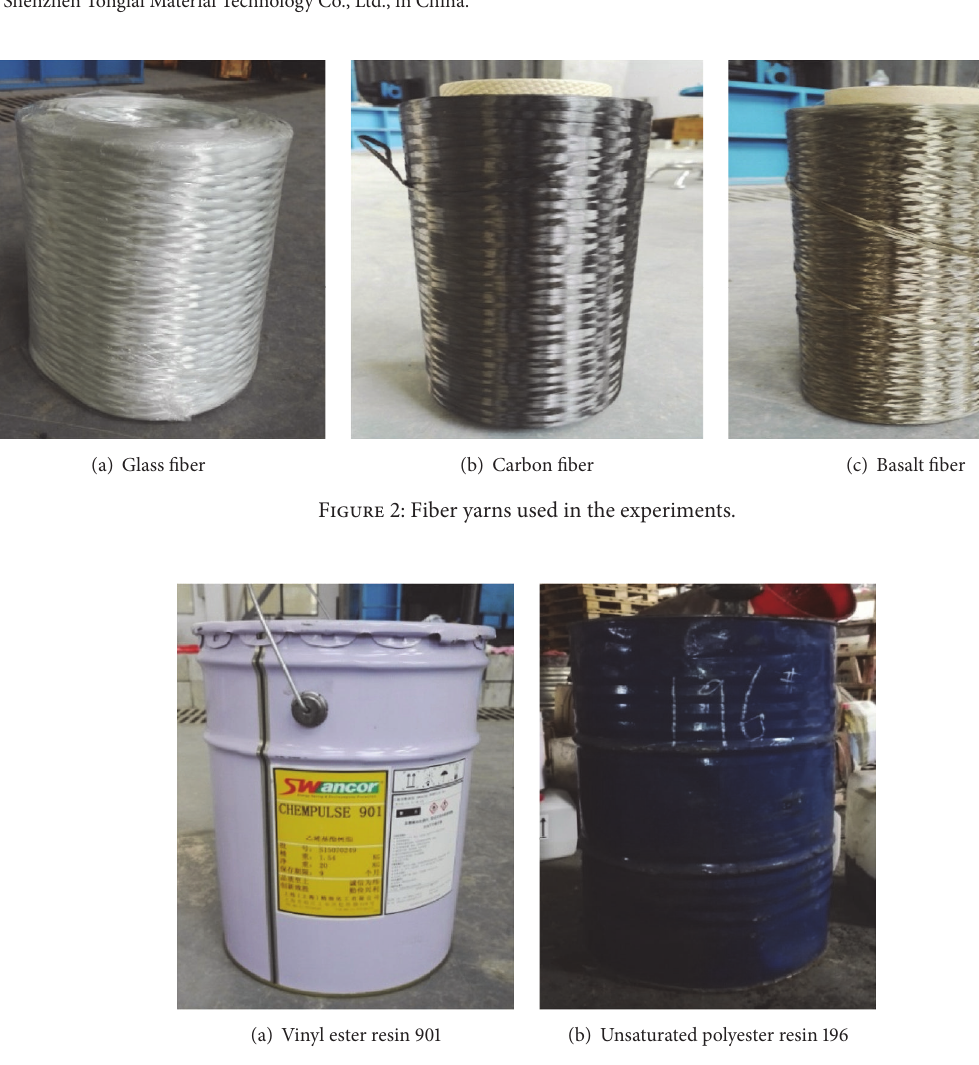
Figure 3: Resins used in the